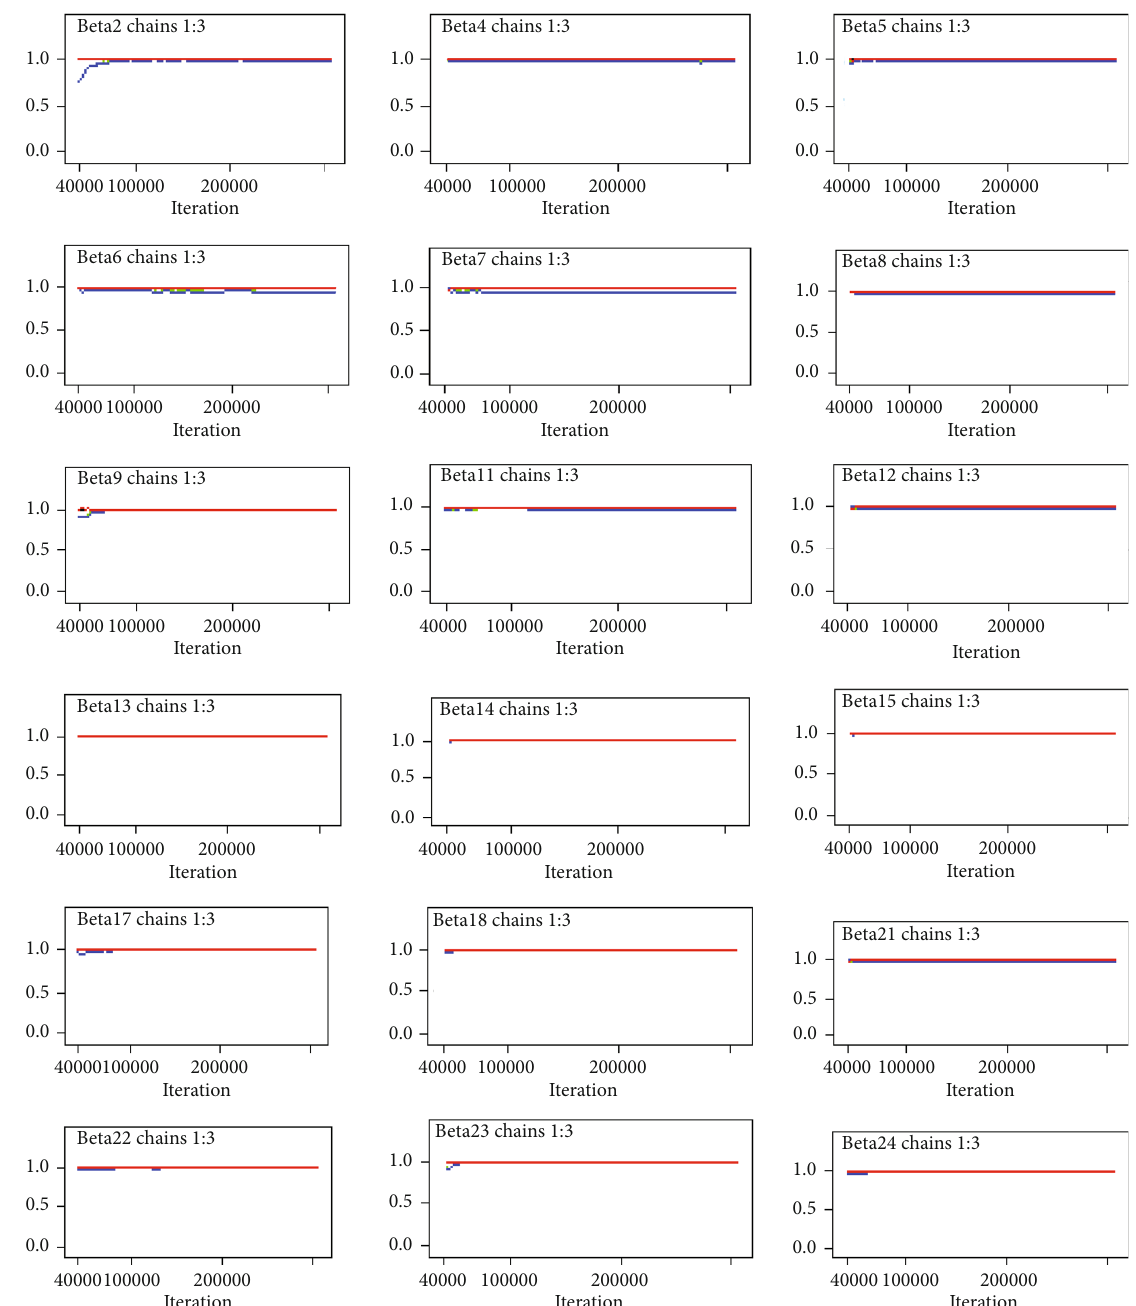
Figure 4: Gelman – Rubin statistic plot of for convergence of coe ffi cients for the